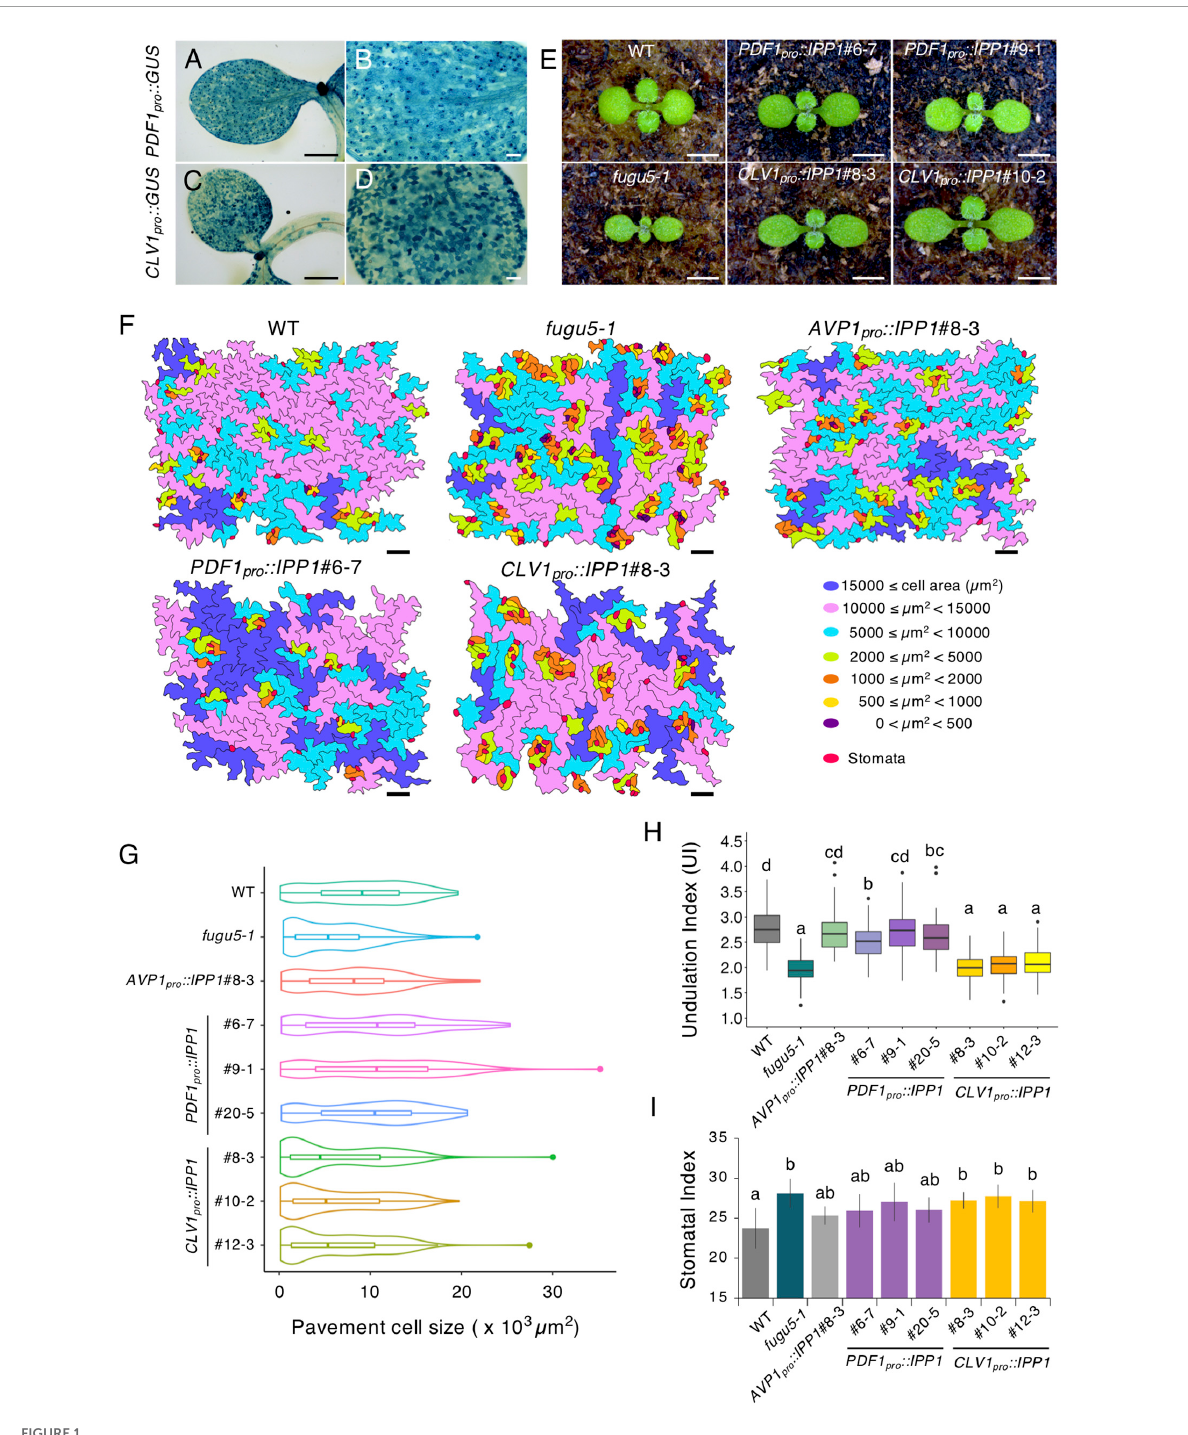
FIGURE1 Phenotypes of transgenic plants expressing IPP1 in a tissue-specific manner. (A–D) The GUS staining of 5-day-old seedlings of PDF1 pro ::GUS and CLV1 pro ::GUS grown on MS medium. (B,D) are magnified images of (A,C) , respectively. Scale bar = 500 µ m (A,C) and 100 µ m (B,D) . (E) Gross morphology of representative transgenic lines grown on rockwool for 10 DAS. Scale bar = 2 mm. (F) Pavement cells (PCs) of the adaxial side on representative scanning electron microscopy (SEM) images were traced and color-coded based on cell size. Scale bar = 100 µ m. (G) Violin plots of the size distribution of PCs, excluding stomata ( n = 200 cells from four independent cotyledons). (H) Box-plot represents undulation index (UI) of PCs ( n = 125 PCs from six cotyledons) at 25 DAS. The boxes of lower and upper are the first and third quantiles, the line in the boxes is the median and whiskers are maximum and minimum values. (I) The stomatal index was determined as the number of stomata per 100 PCs. Results are means ± SD ( n = 6 cotyledons). Each character represents a significant difference at p < 0.05 (Tukey’s HSD test). DAS, days after seed